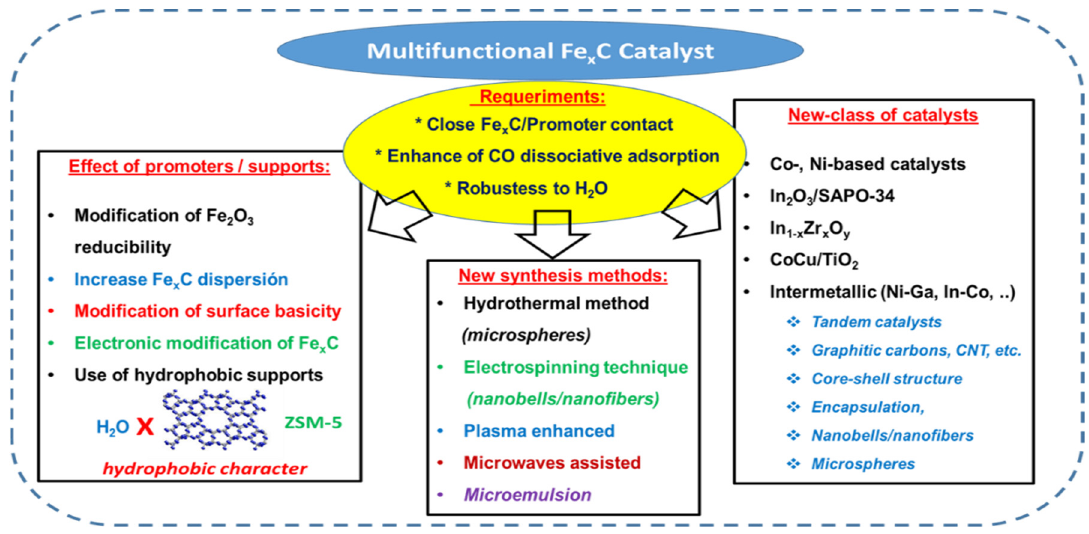
Figure 11. The catalyst requirements for effective C 2 –C 4 = olefin production from CO 2 and the strategies for the preparation of the optimized Fe x C-based